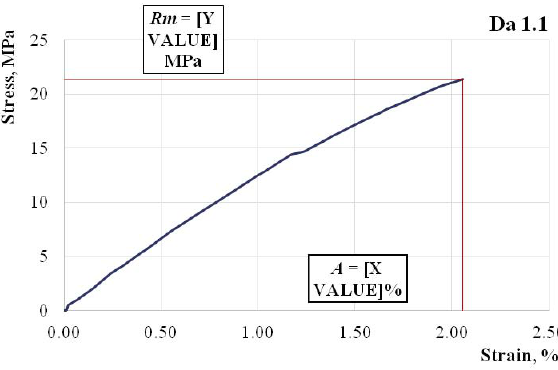
Figure 4. The characteristic curve of a Da 1.x representative sample.